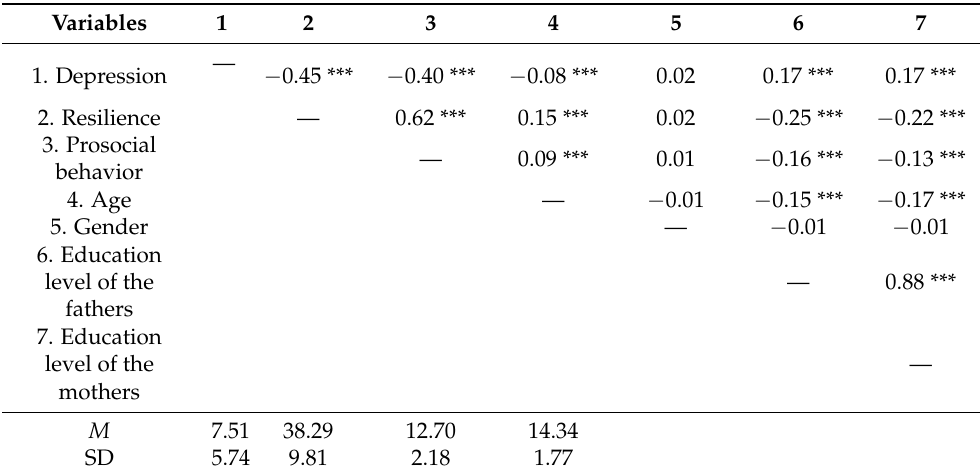
Table 2. Correlations, means, and standard deviations of the study variables ( N = 11,160).